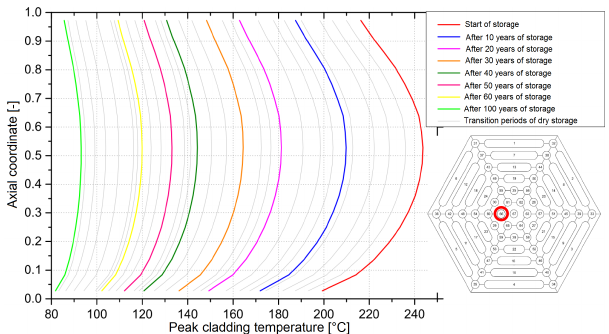
Figure 10. Axial PCT distributions for the hottest rod No.66 in fuel assembly No. 3 at di ff erent times of SNF dry storage in SC CASTOR